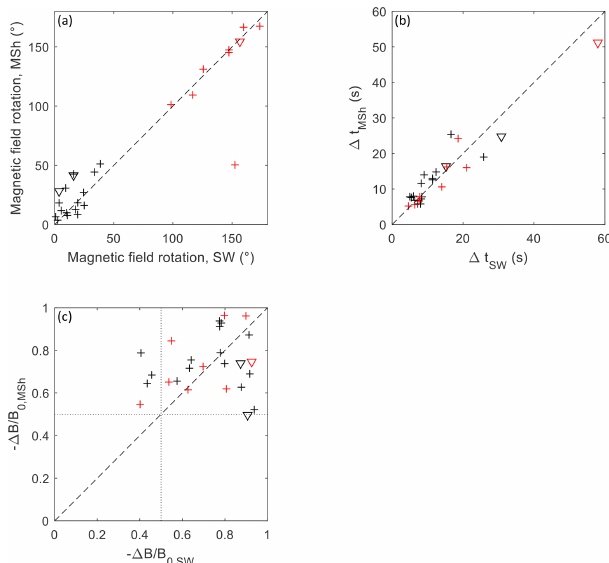
Figure 6. Magnetosheath values versus solar wind values for all 26 magnetic holes. (a) Magnetic field rotation across the magnetic hole, (b) temporal scale size, and (c) magnetic field depth (with the limits of (cid:49)B/B 0 = − 0 . 5 indicated). Black symbols represent linear magnetic holes and red rotational holes. The triangles indicate heavier smoothing, as described in the main